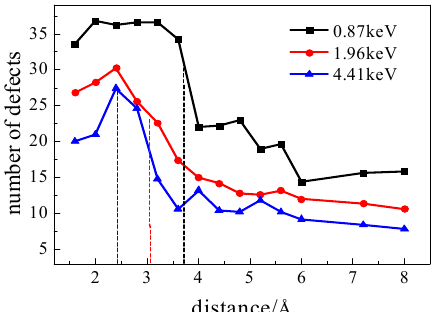
Figure 2. The relationship between defect and irradiation density of suspended single-layer graphene (SLG) at irradiation energy of 0.87, 1.96, and 4.41 keV. The dashed lines indicate the position of (R + r), i.e. the position where the number of knock-on atoms rapidly decreases from the maximum value.